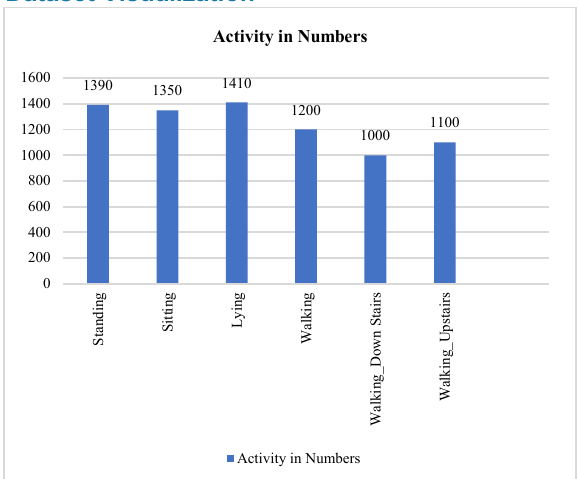
Figure 8. Scatter plot of each activity against its point of